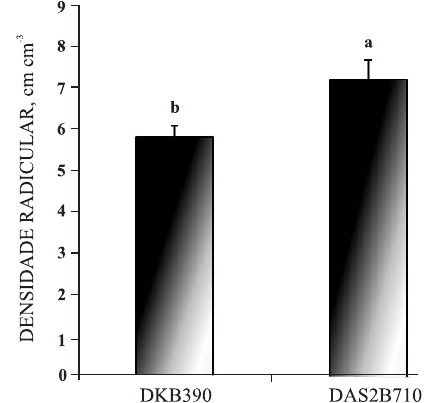
Figura 9. Densidade radicular das cultivares de milho DKB 390 e DAS 2B710 na profundidade de 10–20 cm de um Latossolo Vermelho. As barras referem-se aos erros-padrão das médias.